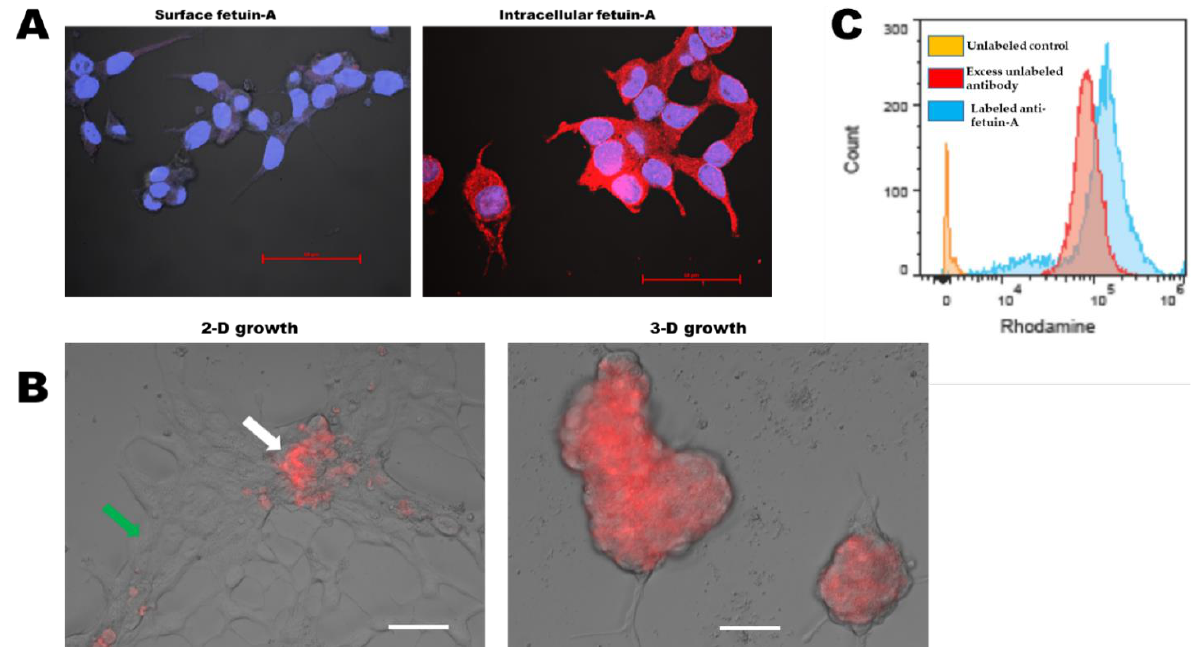
Figure 5. Fetuin-A is rapidly internalized by adhered cells, while in detached or spheroid cells, it remains on the cell surface. In ( A ), left panel, LNCaP cells were cultured on glass coverslips in the presence of fetuin-A (2 mg/mL) for 48 h. The cells were washed 3 × in SFM and then fixed in 3.5% paraformaldehyde in PBS containing 1% BSA for 15 min. They were washed once with PBS and incubated with rhodamine isothiocyanate labeled rabbit polyclonal antibodies to fetuin-A. The cells were washed 5 × with PBS containing 1% BSA, and the glass coverslips were turned upside down on a drop of anti-fade mounting solution with DAPI on microscope slides and images acquired by confocal A1R microscope (Nikon). In ( A ), right panel, LNCaP cells were cultured in SFM containing fetuin-A (2 mg/mL) and fixed in cold methanol for 5 min. They were incubated with rhodamine isothiocyanate labeled rabbit polyclonal antibodies to fetuin-A for 1 h at room temperature, washed, and processed for confocal microscopy (Scale bar = 50 µ m). In ( B ), rhodamine isothiocyanate labeled fetuin-A (50 µ g/well) was added to LNCaP that were grown on high attachment plates (2-D growth) or ultra-low attachment plates (3-D) for 4 days. The images were acquired by a Keyence epifluorescence microscope (scale bars = 50 µ m). In ( C ), detached LNCaP cells were incubated in SFM containing fetuin-A (2 mg/mL) for 30 min at 37 ◦ C. The cells were washed 5 × with cold FACS buffer and fixed in paraformaldehyde. The fixed cells were incubated in cold FACS buffer (unlabeled controls; orange peak) or FACS buffer containing labeled polyclonal anti-fetuin-A (1:100 dilution; blue peak) or in buffer containing both labeled anti-fetuin-A (1:100) and excess unlabeled antibodies (1:5; red peak). The cells were washed 5 × with FACS buffer and then analyzed by flow cytometer. The experiment was repeated 3